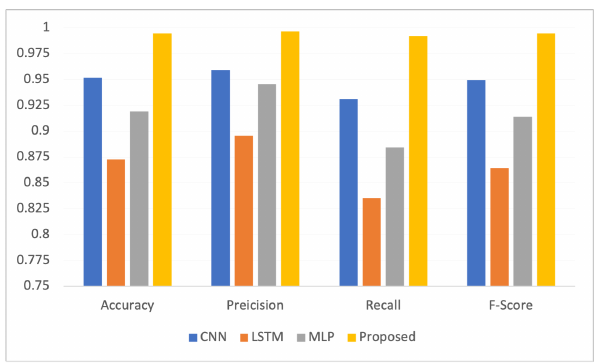
Figure 3. Comparison of proposed model with individual DL models. Table 3. Performance of FLDID framework under 4 different scenarios.